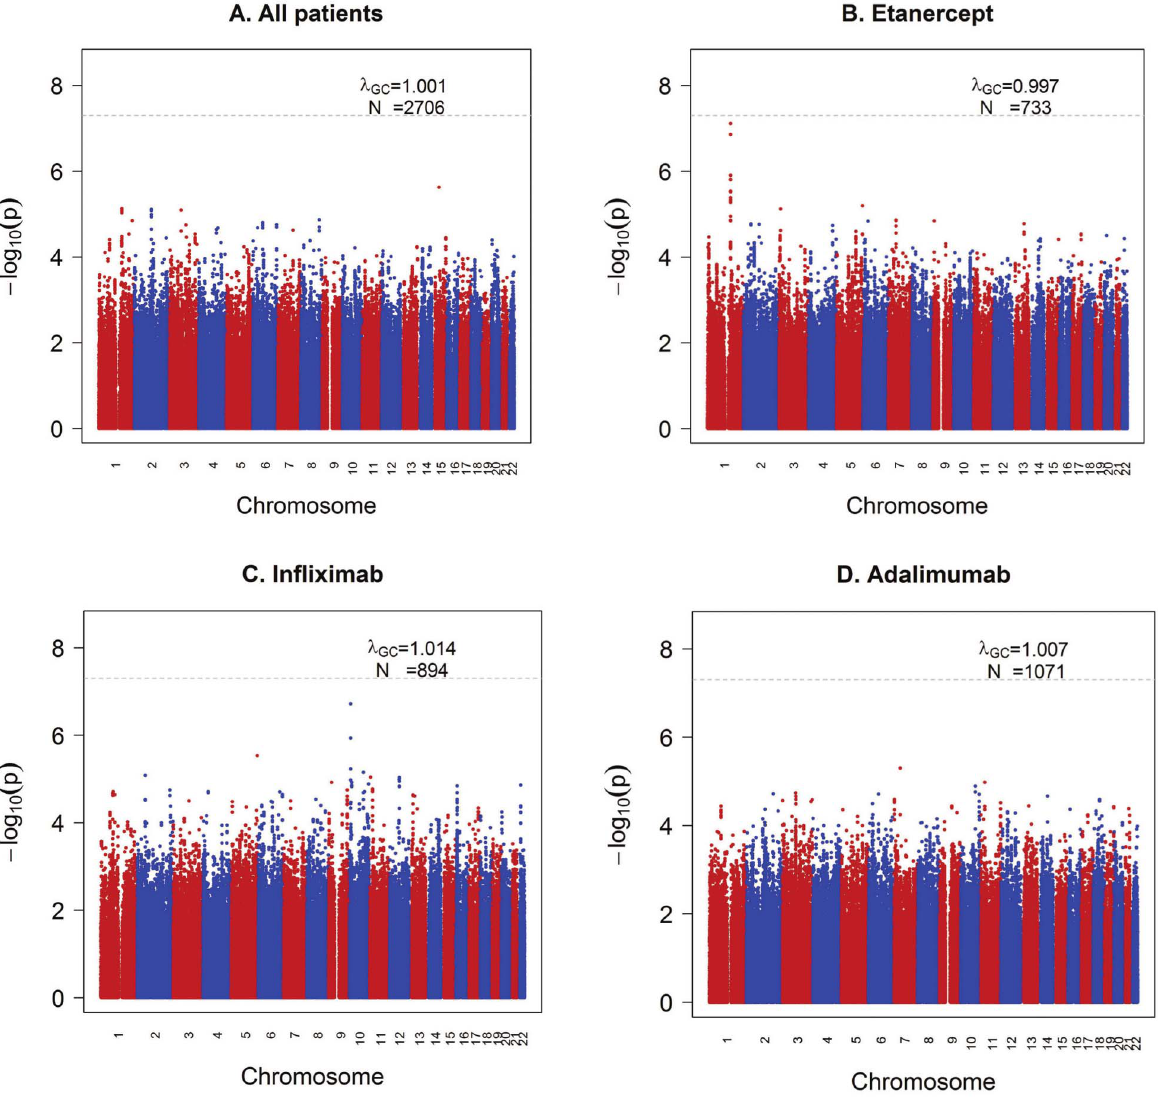
Figure 1. GWAS results for the D DAS phenotype. Shown are strengths of association ( 2 Log10 P-value) for each SNP versus position along chromosomes 1 to 22. A) All samples (n=2,706). B) Etanercept-treated patients (n=733). C) Infliximab-treated patients (n=894). D) Adalimumab- treated patients (n=1,071).